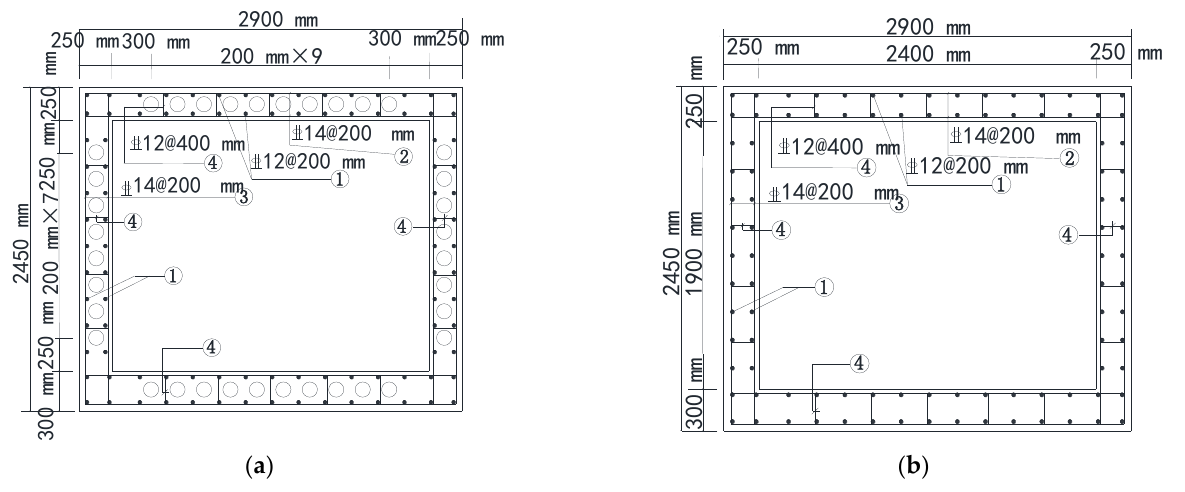
Figure 1. Reinforcement of utility tunnel specimens. ( a ) Reinforcement of ordinary specimens. ( b ) Reinforcement of hollow